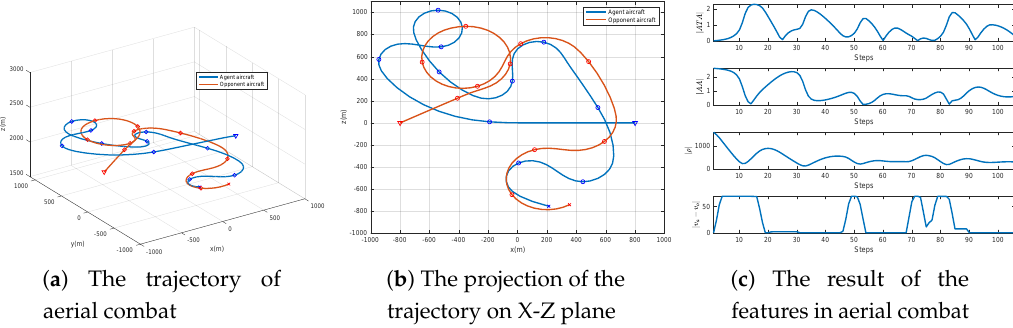
Figure 11. The simulation results of the aerial combat maneuver strategy using the RS-SA-DDPG-1 algorithm against the uniform linear motion maneuver